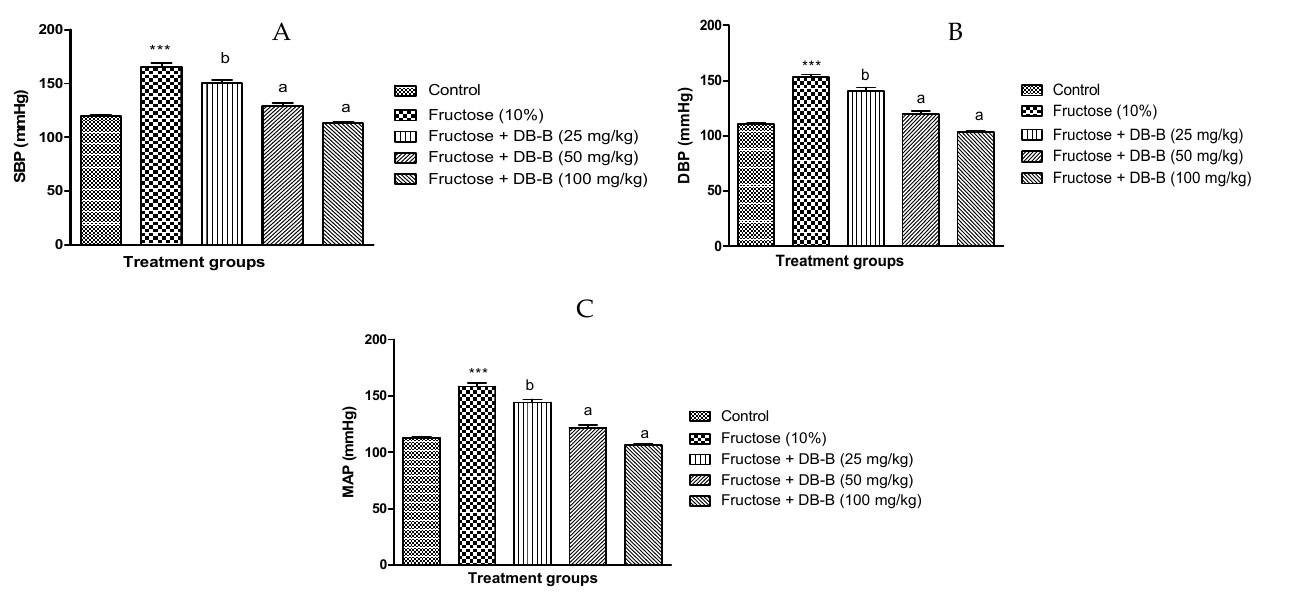
Figure 1. DB-B-mediated fall in blood pressure of fructose-fed hypertensive rats: ( A ) SBP (systolic blood pressure), ( B ) DBP (diastolic blood pressure), ( C ) MAP (mean arterial pressure). Results are expressed as mean ± SEM (n = 5). One-way analysis of variance was applied. *** = p < 0.001 when compared with the control group, whereas a = p < 0.001 and b = p < 0.01 in relation to the fructose (10%) group.